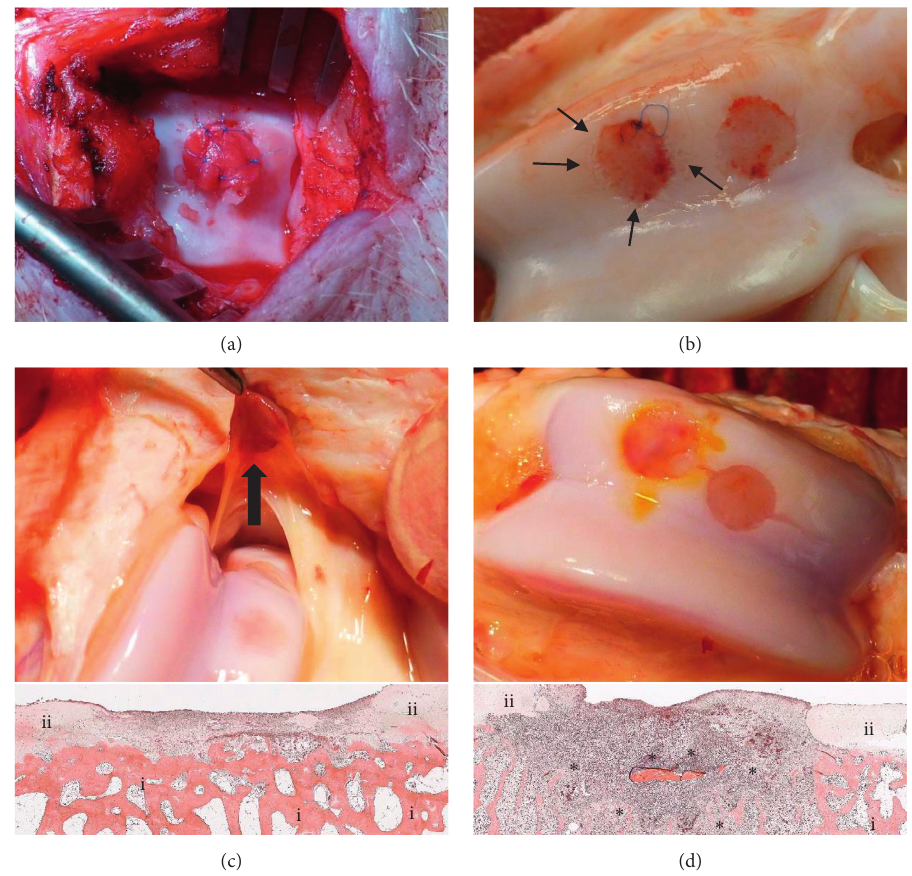
Figure 2: Fixation of novel constructs in chondral trochlea defects. Covering the construct with Chondro-Gide ® resulted in intraoperative squeeze out of the hydrogel (a). CCT-reinforced hydrogels were directly sutured to the surrounding cartilage. None of the constructs remained in place after 4 weeks. Macroscopic changes to the surrounding cartilage due to suture tear out (thin arrow) were observed (b). Fibrin glue was used to fix a precasted hydrogel with CCT-reinforcement in a 6mm trochlea defect. After 4 weeks, the displaced construct was found within the synovial tissue (big arrow), H and E staining (c). BioGlue ® led to macroscopic colour changes of the surrounding cartilage as well as microscopic bone lysis (H&E staining) of the subchondral bone plate ( ∗ ) (d). Scale bar: 2mm; i : bone; ii : cartilage; ∗ : bone